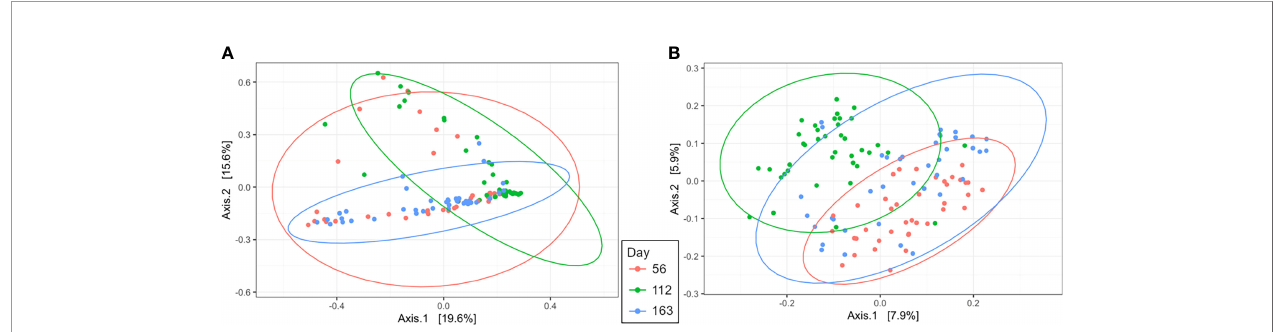
FIGURE 5 | Beta diversity by principal coordinate analysis with Bray Curtis distances for day of supplementation in the uterus ( A ; R 2 = 0.10, P = 0.001) and rumen ( B ; R 2 = 0.08, P = 0.001). Signi fi cance was determined by PERMANOVA with 999 permutations. Ellipses represent 95% con fi dence